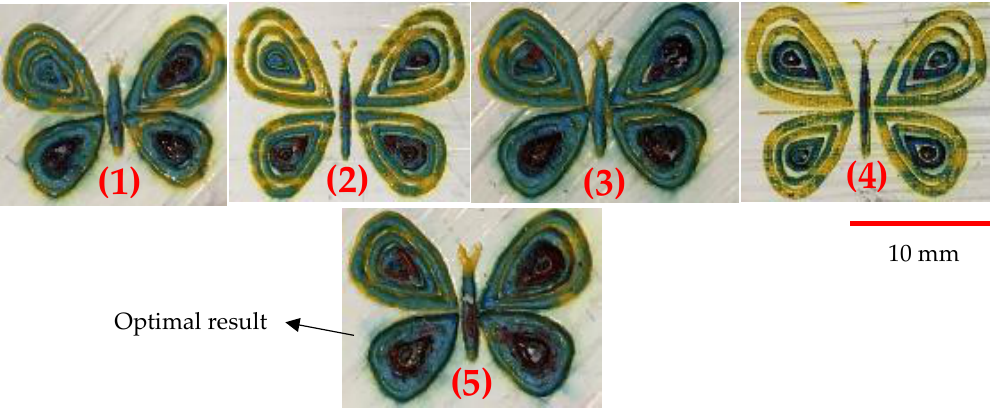
Figure 22. Different color designs of butterfly, 1 – 4: Different laser parameters (Table 3), 5: Optimum parameters (Table 4).